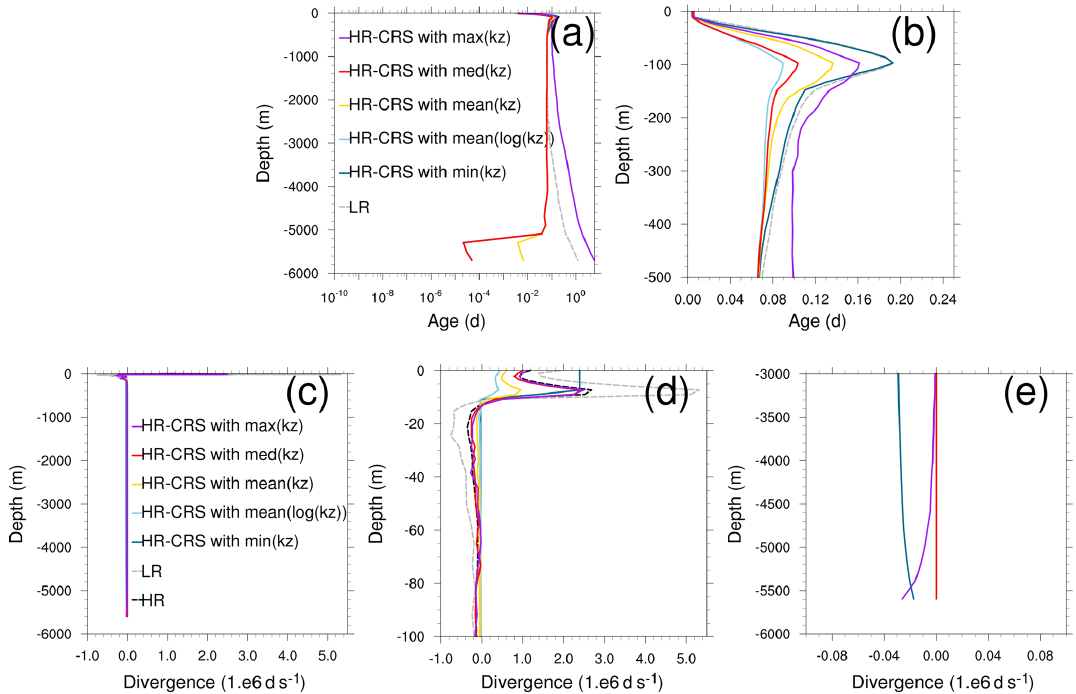
Figure 8. (a, b) The rms differences to HR age tracer for HRCRS and LR runs for the whole water column (a) and for the first 500m (b) . The age tracer values are instantaneous outputs after 1 year. (c–e) Horizontal mean of divergence of age tracer vertical diffusive flux mean over the first year for the whole water column (c) , the top ocean (d) and the bottom ocean (e) .